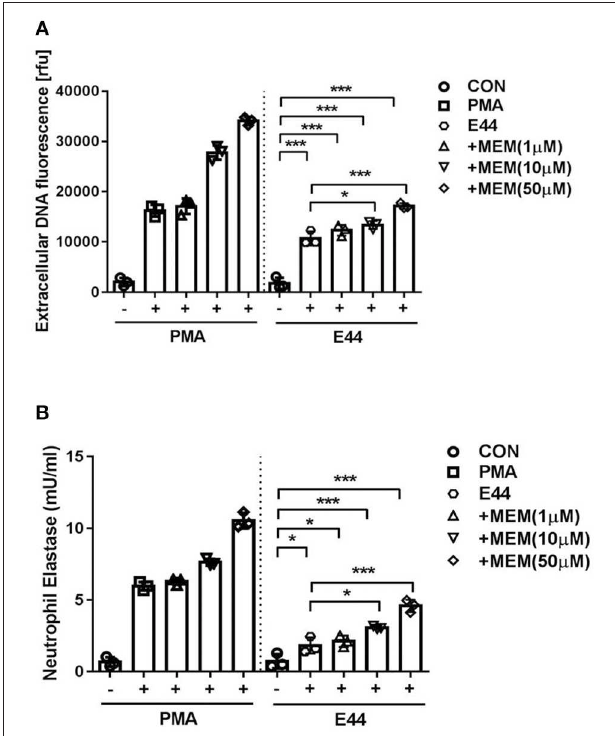
FIGURE 1 | MEM enhanced E44-induced formation of NETs. (A) Detection of extracellular DNA using fluorescence microscope after the neutrophils infection with E. coli E44. A number of 1 × 10 5 collected PMNs was cultured in 96 well-plates. The cells was treated with 100nm PMA (positive control) or E44 for 4h. Then the released DNA was detected with the DNA fluorescent dye of Picogreen; (B) The expression levels of neutrophil elastase (NE) in neutrophils treated with PMA or E44 along with MEM. Bar graphs show the means ± SD of three different experiments. Scatter plots in the bar graphs represent the three biological replicates. Significant differences with regard to the controls are marked by asterisks (* P < 0.05; *** P <